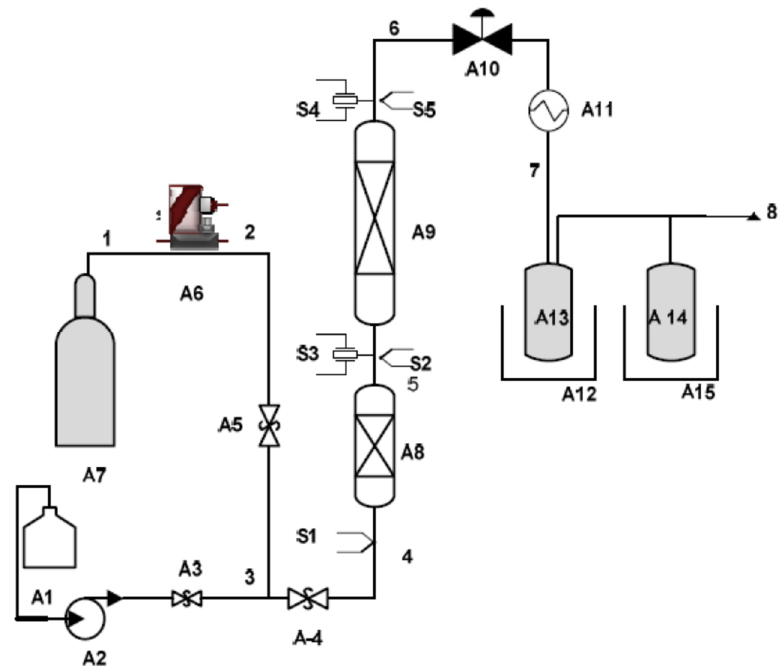
Figure 2. A1—Ethanol tank; A2—HPLC pump; A3, A5—Check valves; A4—relief valve; A6—Flow mass controller, A7—Cylinder containing a mixture of hydrogen 5% and nitrogen; A8—pre-heater to vaporize ethanol; A9—Stainless steel packed bed tubular reactor. A10—Back pressure regulator; A11—Heat exchanger; A13, A14—Product tanks raising; A12/A15—Liquid nitrogen dewars; S1/S2/S5—Temperature probes; S3/S4—Pressure transducers. The reactor A9 was heated by two independently thermoregulated heaters.